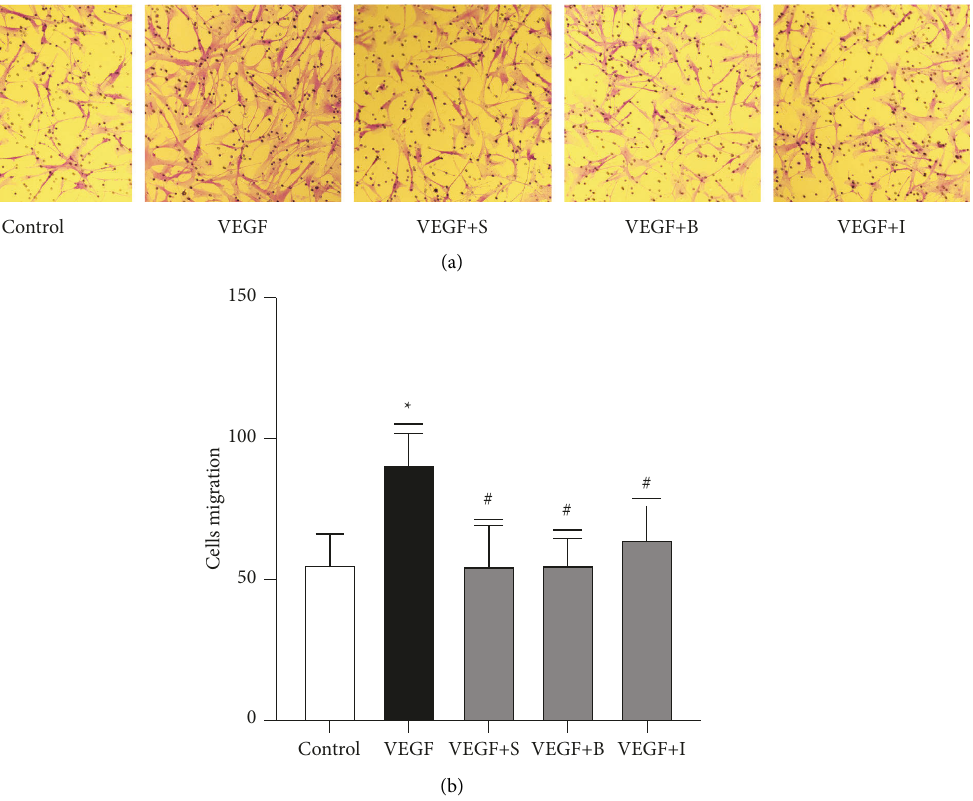
Figure 5: Salbutamol, budesonide, and ipratropium bromide inhibited VEGF-induced ASMC migration. (a) A representative image of cell migration. (b) The number of migrating cells in each group, and the data are expressed as the mean ± standard deviation (M ± SD). ∗ The VEGF group result was significantly different from the control group result ( P < 0 . 05). # There are significant differences between the VEGF+S group, VEGF+B group, and VEGF+I group and VEGF group ( P < 0 . 05). VEGF+ S represents the VEGF +salbutamol group, VEGF+B represents the VEGF+budesonide group, and VEGF+I represents the VEGF+ipratropium bromide